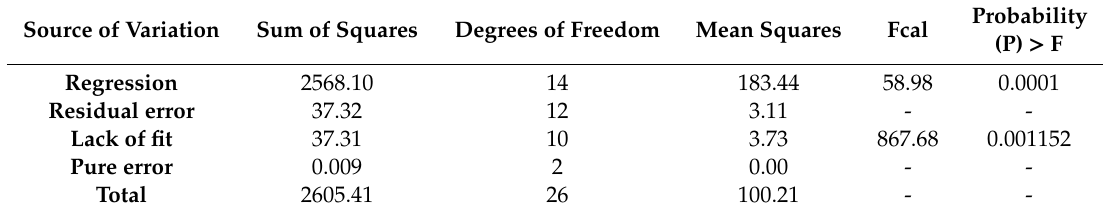
Table 5. Analysis of variance (ANOVA) for the empirical